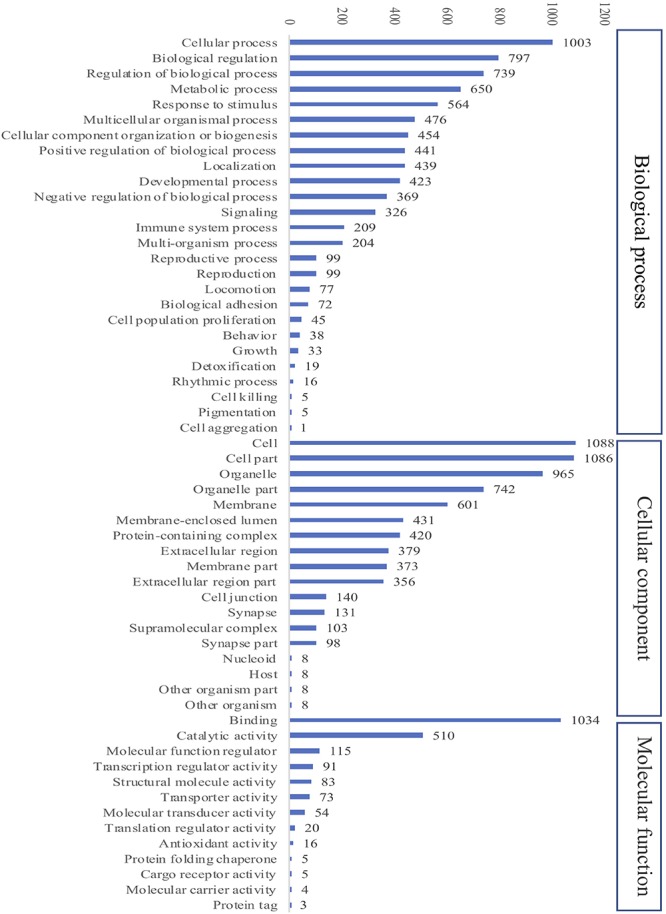
Gene Ontology (GO) analysis of all identified proteins in striped catfish liver after 6 weeks of extract-based diets. The number of proteins in three categories including Cellular component, Biological process and Molecular function.